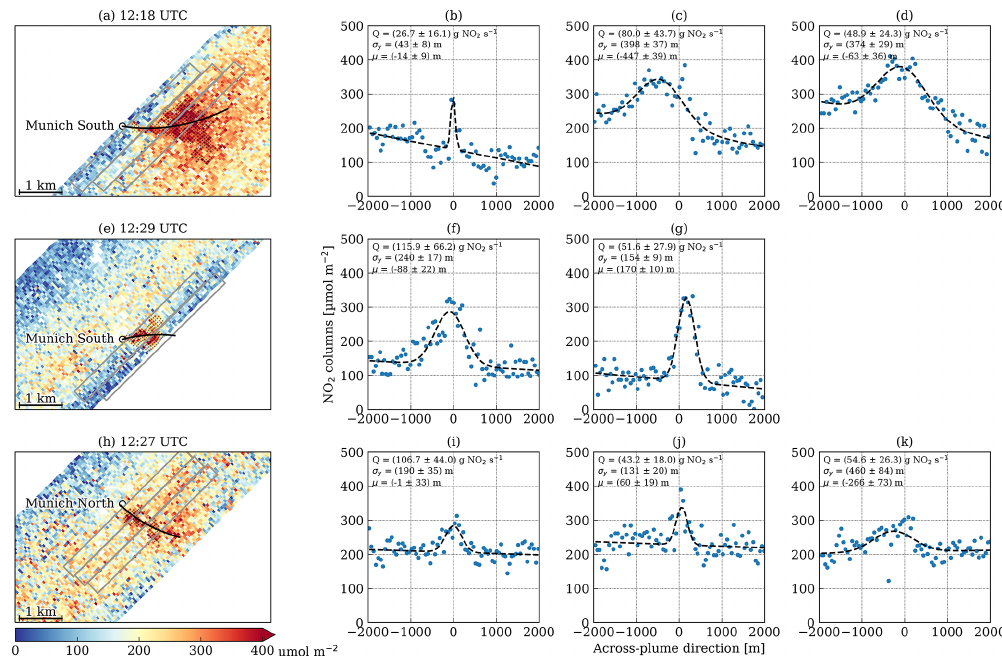
Figure 11. (a, e, h) APEX NO 2 maps with emission plumes (black dots) of the Munich South and Munich North CHP plants. The center line of the plume is shown as a black curve. (b–d, f, g, i–k) APEX NO 2 VCDs averaged in the across-track direction within gray boxes shown in the maps and a Gaussian curve fitted to the observations (dashed